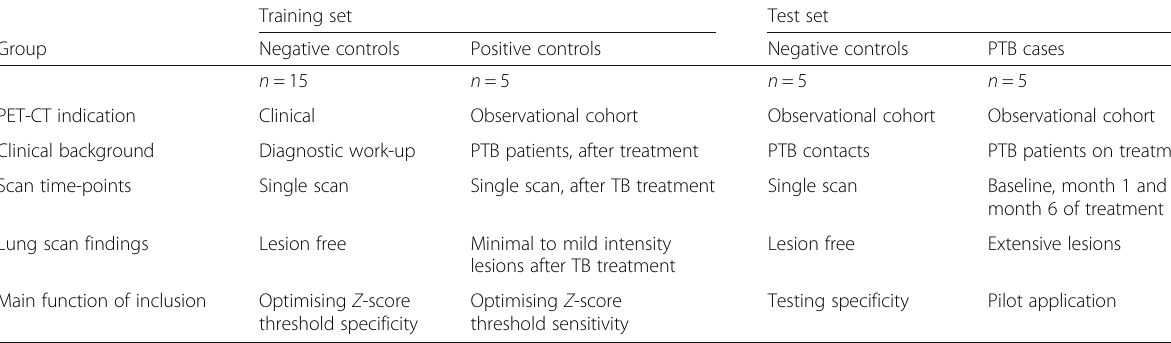
Table 1 Study design for method development and pilot application Training